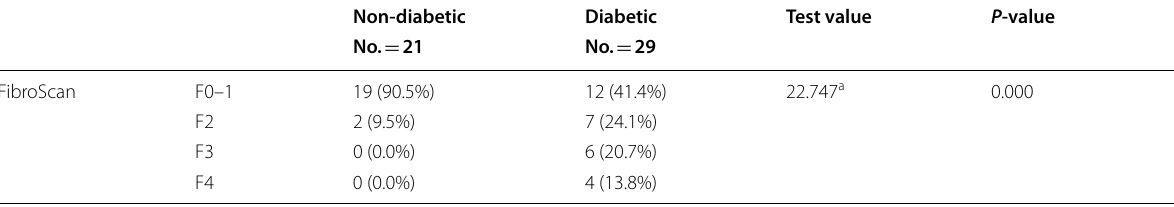
P -value > 0.05, non-significant; P -value < 0.05, significant; P -value < 0.01, highly significant